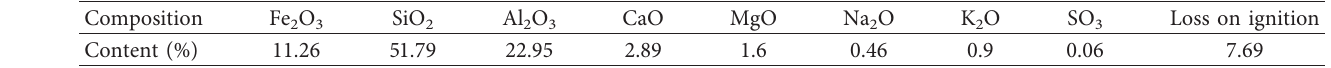
Table 1: Chemical composition of fly ash.